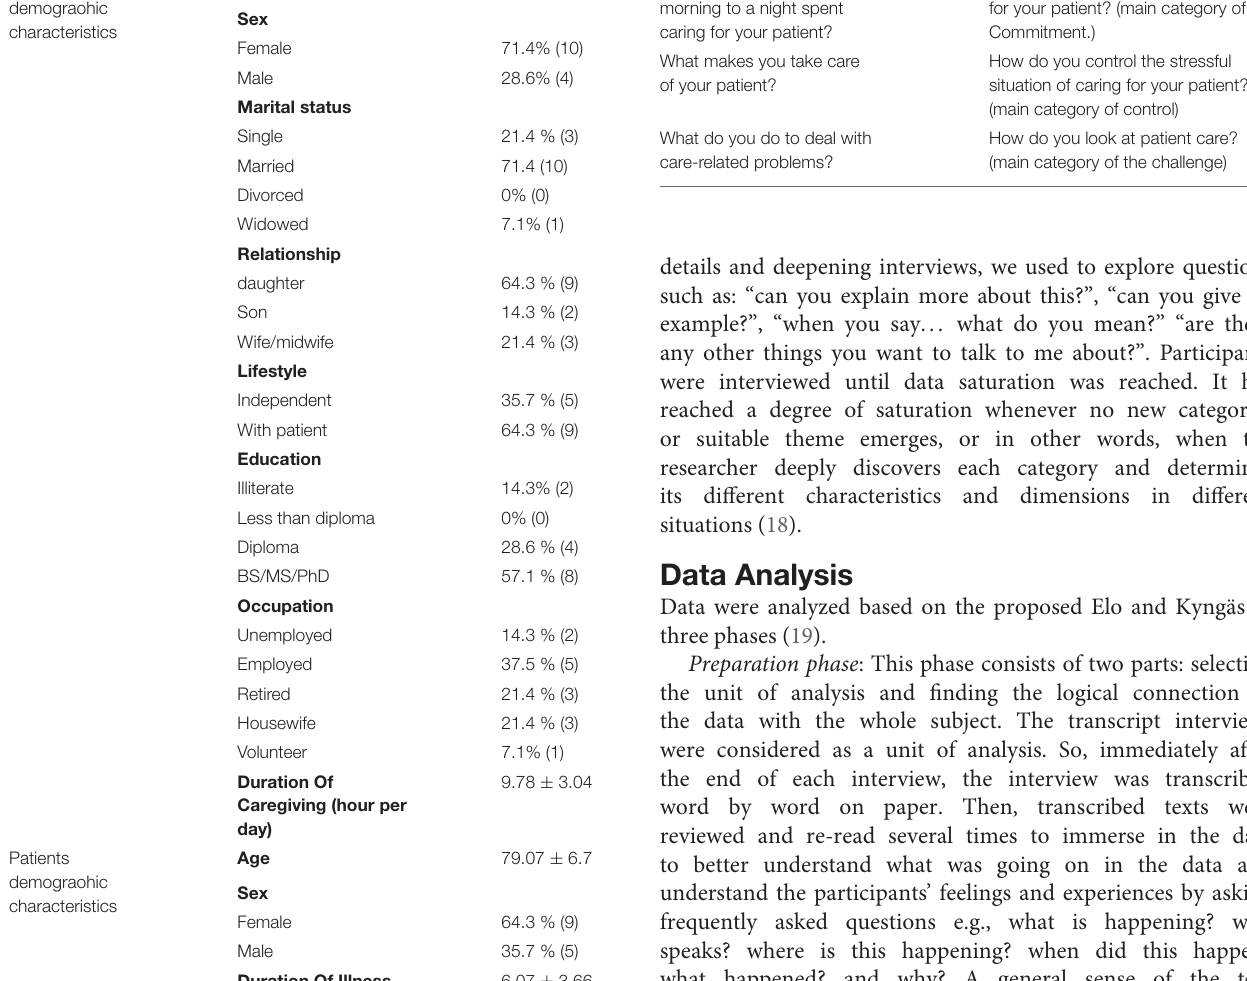
TABLE 1 | Demographic characteristics of patients and caregivers. Group Variables Caregiver demograohic characteristics